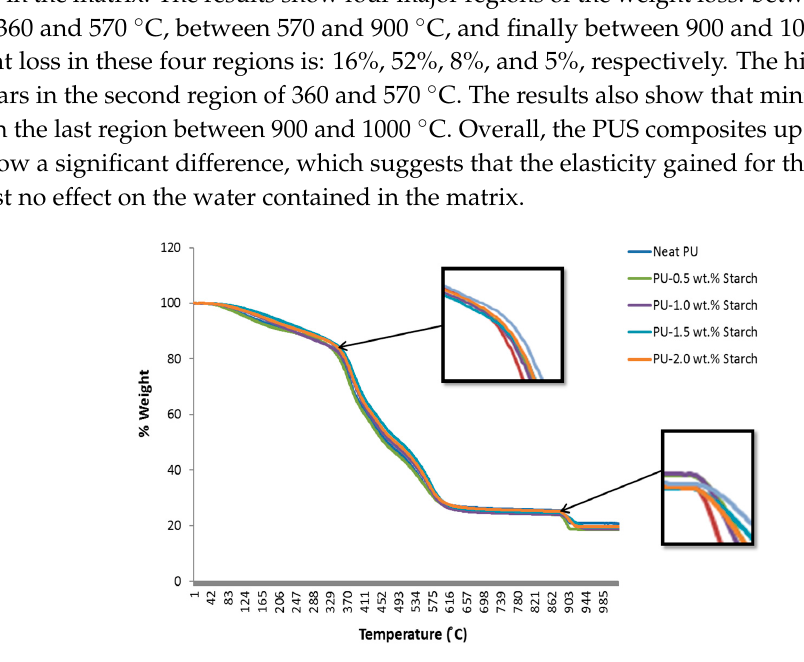
Figure 10. Thermogravimetric analysis of PU and PUS composites.